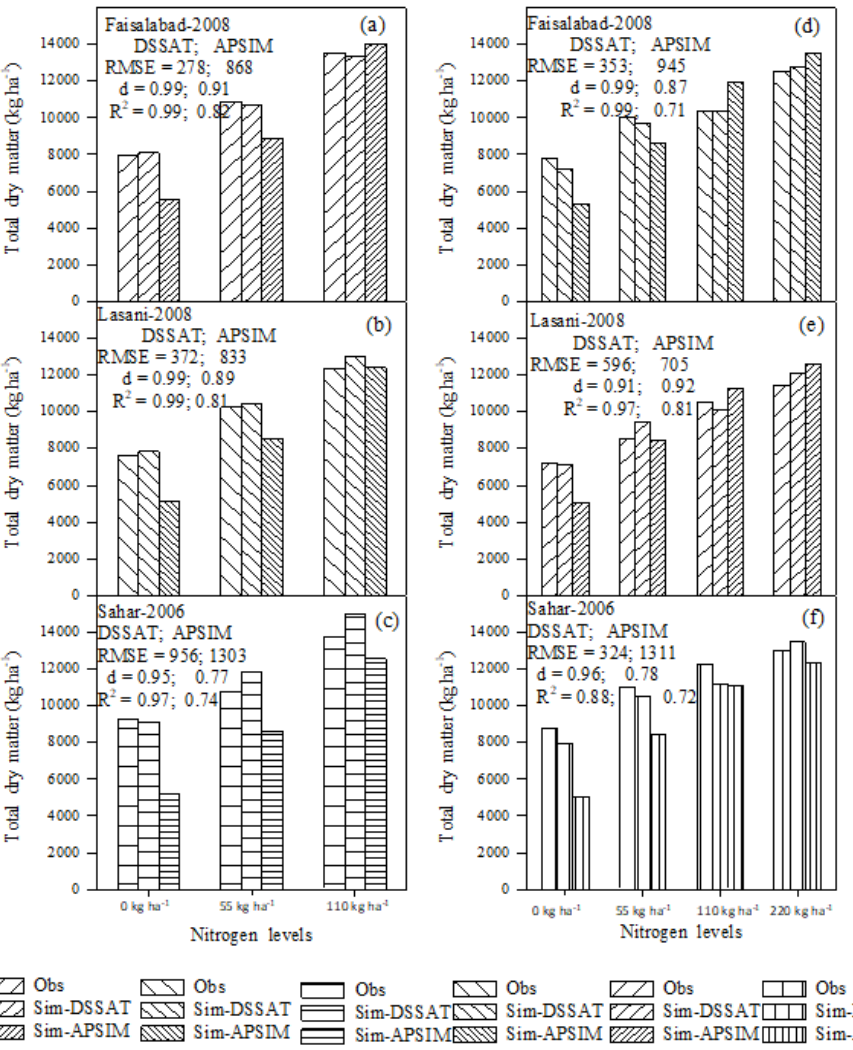
Figure 6. Intercomparison of simulated and observed total dry matter (kg ha −1 ) at different nitrogen levels for wheat cultivars during years 2008 – 2009 ( a – c ) and 2009 – 2010 ( d – f ). Simulation of TDM by both crop models during the growing year (2009 – 2010) were closely related to the observed values with less RMSE of 424 and 986 kg ha − 1 , higher d index (0.97 and 0.86) and R 2 values of 0.95 and 0.75 for CERES and APSIM-Wheat, respec-